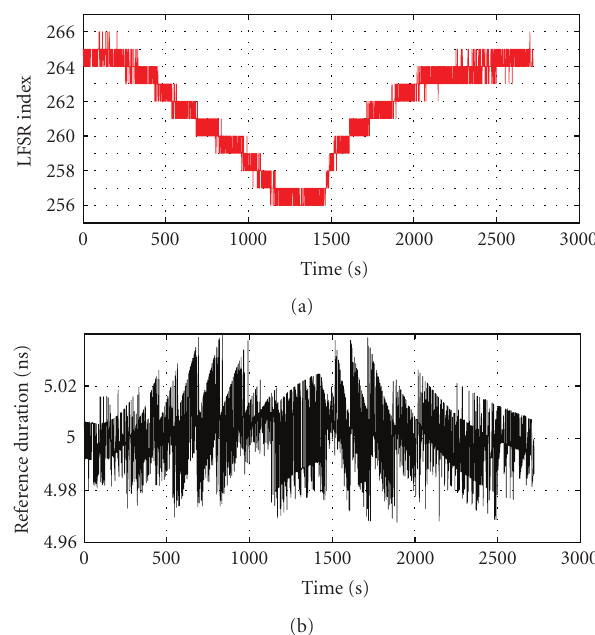
Figure 12: ref-val versus timer reference period for tempera-